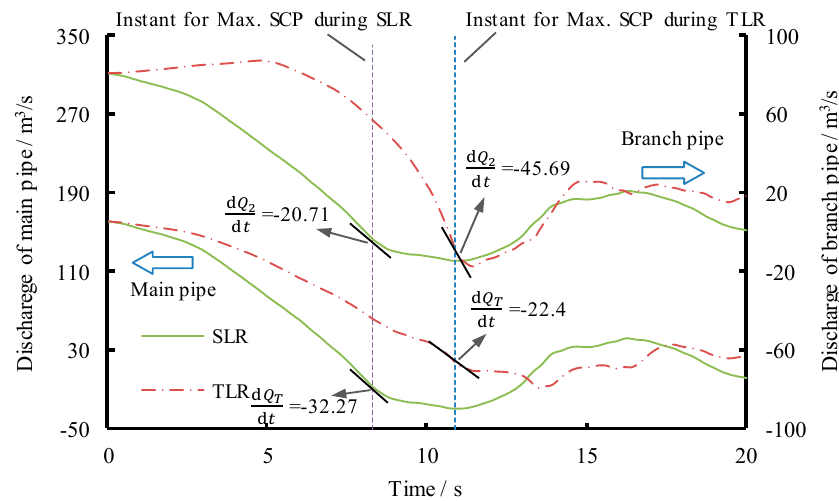
Figure 9. Discharge of the main and branch pipes versus time during SLR and TLR for η 1 = 0.71.